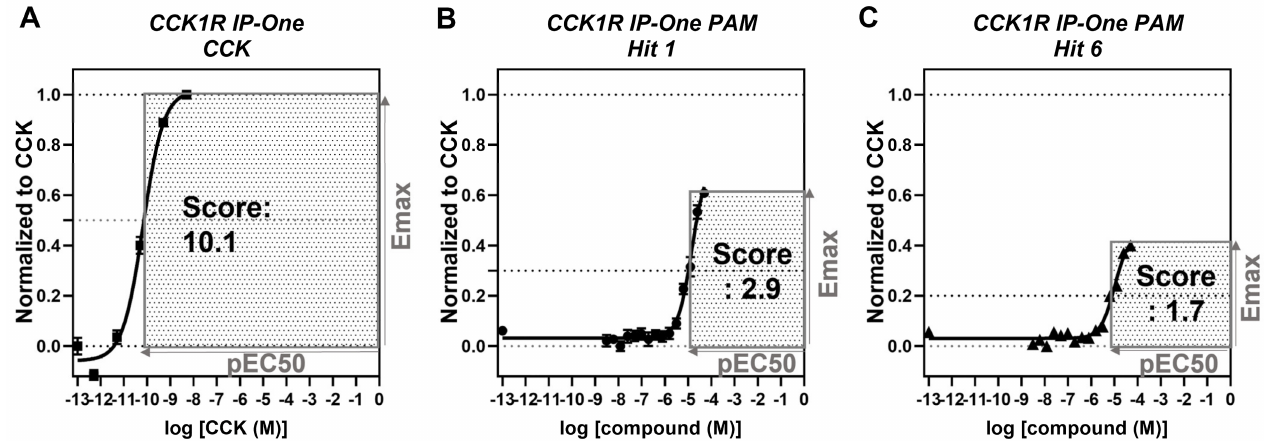
Figure 5. Activity score represents an approximation of the AUC of compound dose–response curves. IP-One dose–response of ( A ) CCK-8, ( B ) “hit 1”, and ( C ) “hit 6” in HEK-293 CCK1R cells; TR-FRET ratios resulting from IP-One accumulation normalized to CCK (E max = 1) with ( A ) DMSO or ( B , C ) EC 20 CCK as negative control (E max = 0), representing ( A ) agonist and ( B , C ) PAM screening format, respectively; activity score was calculated by multiplying pEC 50 with normalized E max , and the corresponding area is highlighted in grey; graphs plotted using GraphPad Prism; experiments performed in duplicate in at least three independent experiments; data points shown as mean ±